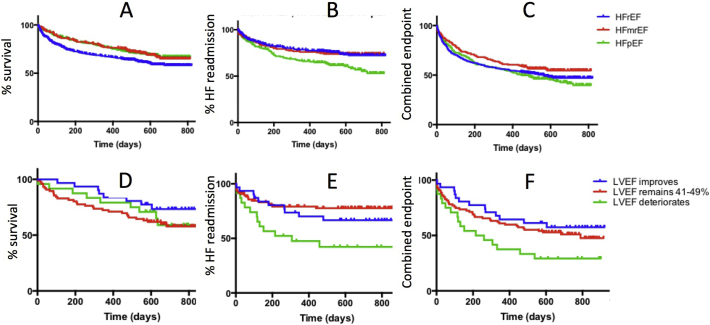
A: Kaplan Meier survival free of all cause death for all HF patients; p = 0.0256 HFrEF v HFpEF; 0.0298 HFrEF v HFmrEF, NS HFpEF v HFmrEFB: Kaplan Meier for time to HF readmissions for all HF patients; p = 0.0012 HFpEF v HFrEF, NS HFmrEF v HFrEF, p = 0.009 HFmrEF v HFpEFC: Kaplan Meier for time to combined endpoint (all cause death/HF readmissions) for all HF patients; p = 0.0399 HFpEF v HFmrEF, NS HFrEF v HFmrEF, NS HFrEF v HFpEFD: Kaplan Meier for time to all cause death in all patients with HFmrEF; p = 0.04 LVEF remain v improve, p = 0.28 remain v deteriorate, p = 0.56 improve v deteriorateE: Kaplan Meier for time to HF readmissions in all patients with HFmrEF; p = 0.56 LVEF remain v improve, p < 0.01 remain v deteriorate, p = 0.04 improve v deteriorateF: Kaplan Meier for time to combined endpoint (all cause death/HF readmissions) in all patients with HFmrEF; p = 0.36 LVEF remain v improve, p 0.06 remain v deteriorate, p = 0.02 improve v deteriorate.